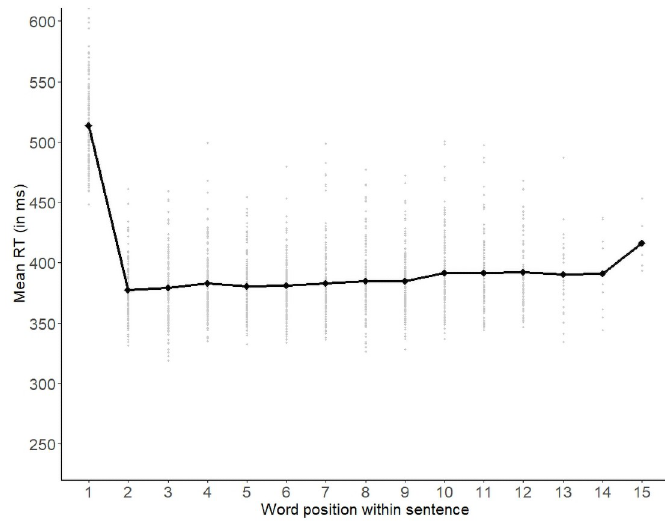
Fig 1. Average word RTs by word position. Black dots represent average RTs for each word position. Gray dots represent average RTs per word per sentence. Note that only five sentences had a length of fifteen words.